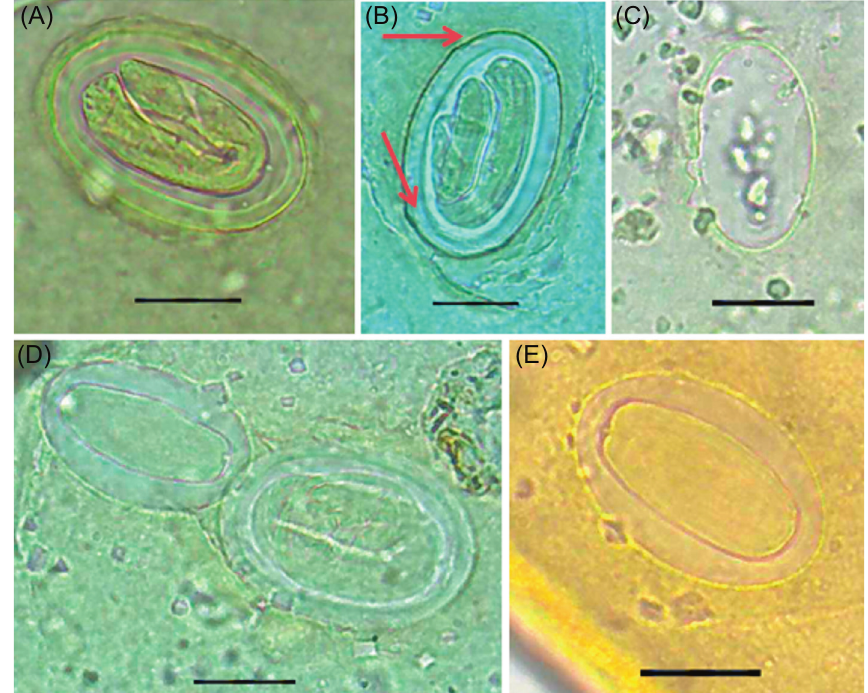
Figure 3. The six Physaloptera spp . eggs found in the soil sample. Note the embryos in A, B, D. Arrows in (B) show the considerable thickness of the egg shell. The diagnosis cannot be made with certainty for the egg in (C). Scale bars = 20 l m. Egg shows a hyalinized state of its content